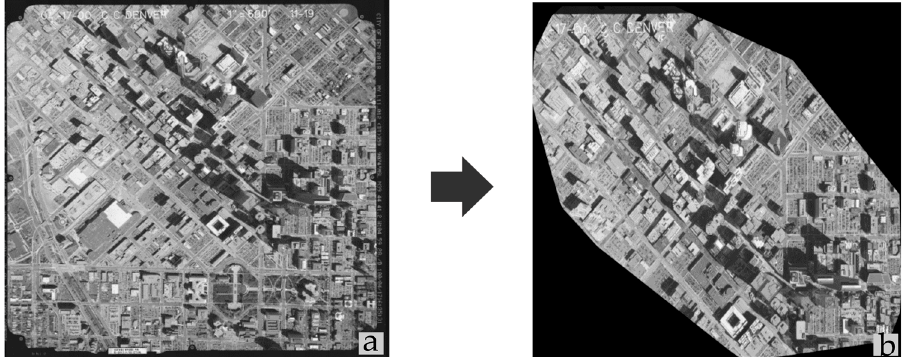
Figure 1. ( a ) is the aerial image. ( b ) is the ghost image.